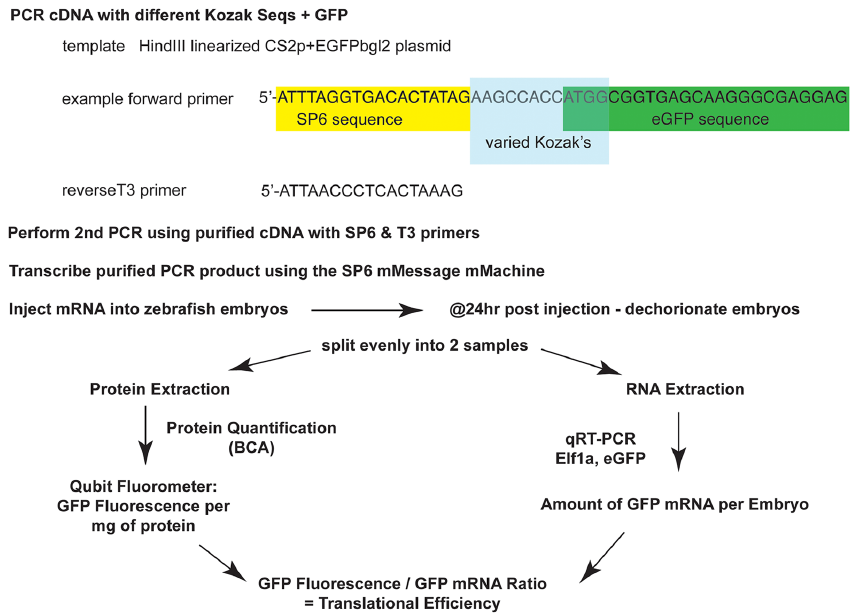
Figure 3. Schematic of a PCR-based method to correlate Kozak sequence with translation efficiency. Following PCR reactions with nested primers, the purified PCR product is transcribed and the RNA quantified and injected into 50 embryos per RNA product. At 24 hours post injection, the embryos are divided into 2 groups of 25 embryos – one group is used for RNA extraction, to validate the amount of RNA that was injected, and the other group is used for protein extraction, to assess translation. elf1a was used as an endogenous normalization control for qRT-PCR. Fluorescence from eGFP is normalized to total protein (see text and Figure S1).